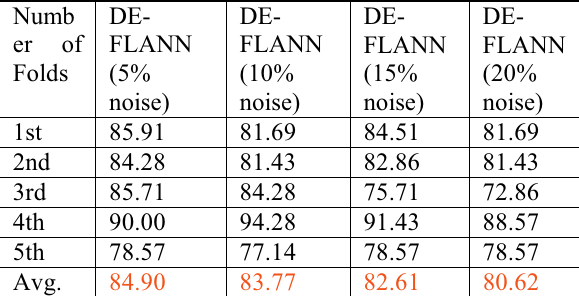
Figure 5: IRIS-Iteration vs. Error